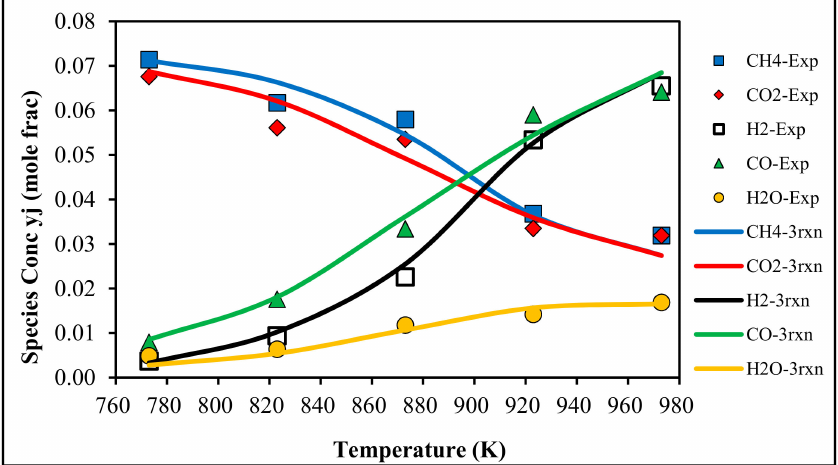
Figure 8. Comparison of experimental and 3-reaction model-based outlet concentrations for cases: CH 4 / CO 2 = 1.0 and GSV = 5.56 × 10 − 4 m 3 /